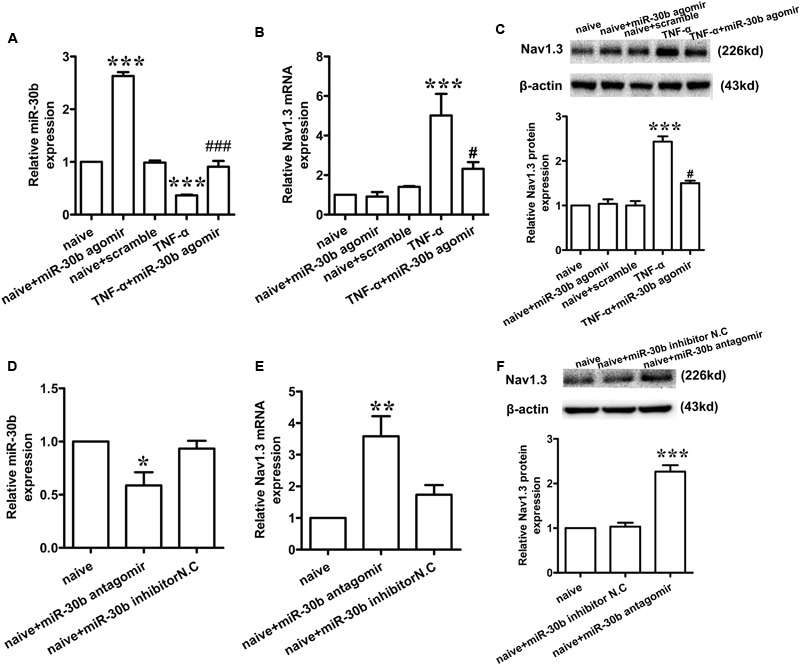
miR-30b regulated the expression of Nav1.3 in primary cultured DRG neurons. (A–C) The relative expression of miR-30b (A) and Nav1.3 mRNA (B) and protein (C) treated with TNF-α and miR-30b agomir/scramble in primary cultured DRG neurons, ∗∗∗P = 0.0007, ∗∗∗P = 0.0010 vs. naïve, ###P < 0.0001 vs. TNF-α; ∗∗∗P = 0.0003 vs. naïve, #P = 0.042 vs. TNF-α; ∗∗∗P < 0.0001 vs. naïve, #P = 0.0162 vs. TNF-α. One-way ANOVA, n = 3 rats. (D–F) The relative expression of miR-30b (D) and Nav1.3 mRNA (E) and protein (F) treated with miR-30b antagomir in primary cultured DRG neurons, ∗P = 0.0140, ∗∗P = 0.0043, ∗∗∗P = 0.0001 vs. naïve, one-way ANOVA, n = 3 rats. Data are shown as means ± SEM.